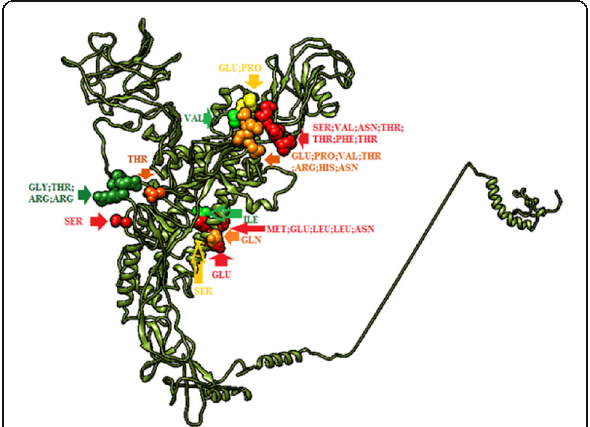
Fig. 5 The position of proposed discontinuous B cell epitopes in the 3D structure of spike protein of IBV illustrated by UCSF-Chimera visualization tool